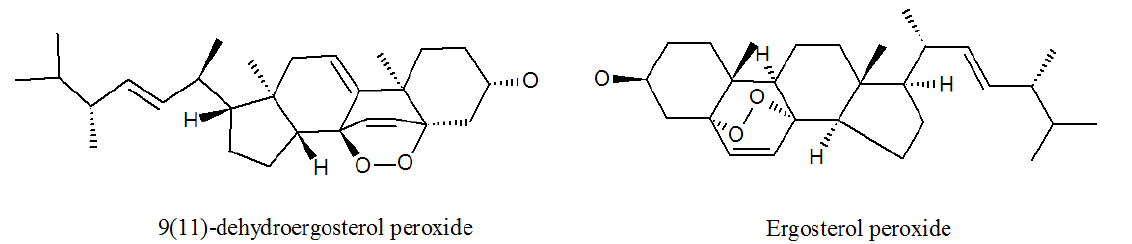
Figure 8. The structures of ergosterols.